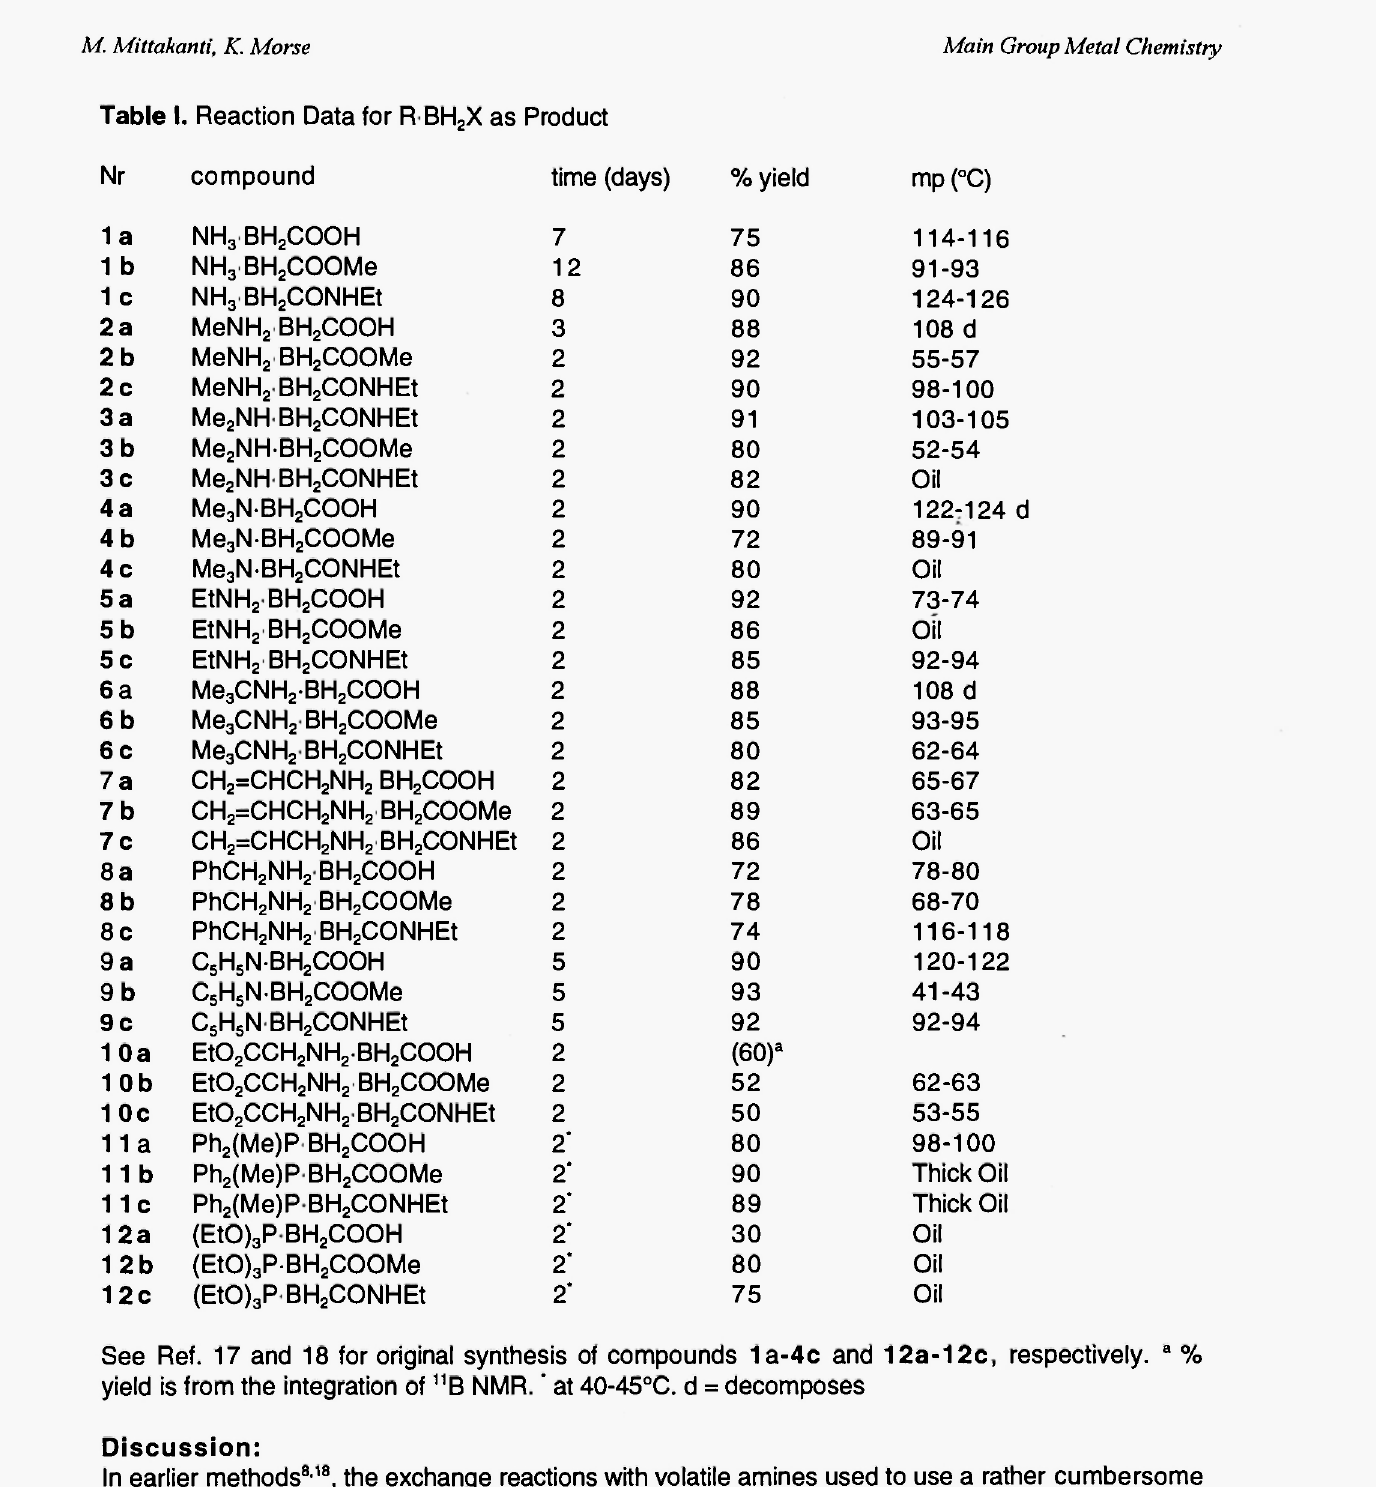
Table I. Reaction Data for RBH